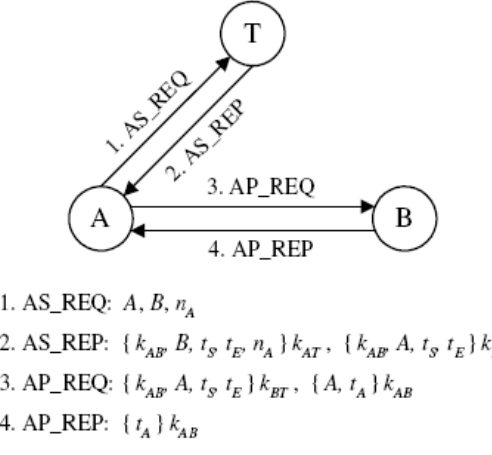
Figure 3. Message exchange in the simplified Kerberos protocol.